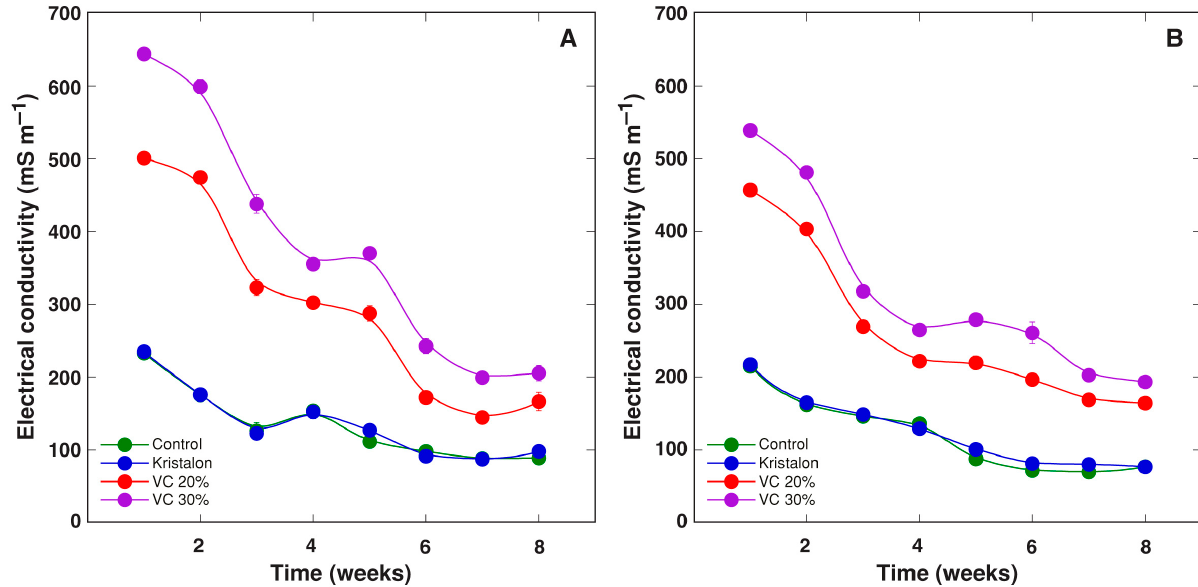
Figure 1. Changes of substrate electrical conductivity as affected by mineral fertilizer (Kristalon) and amendment with vermicompost (VC) at a 20% and 30% ( v/v ) rate during cultivation of Dracocephalum moldavica plants in peat substrate ( A ) or commercial garden soil ( B ). Results are means ± SE from five replicates for each treatment, four measurements per replicate.